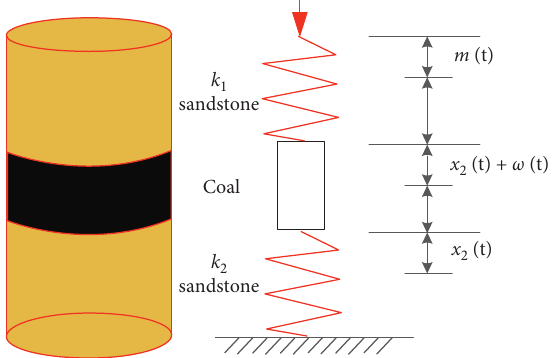
Figure 9: Combined sample mechanical model.